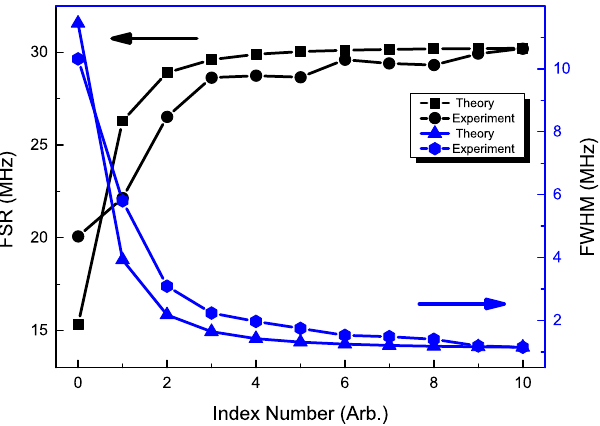
Figure 9. Experimental results and theoretical results of FSR and linewidth of a 3.4 m long PSFBG-F-FBG resonator, plotted versus the index number.